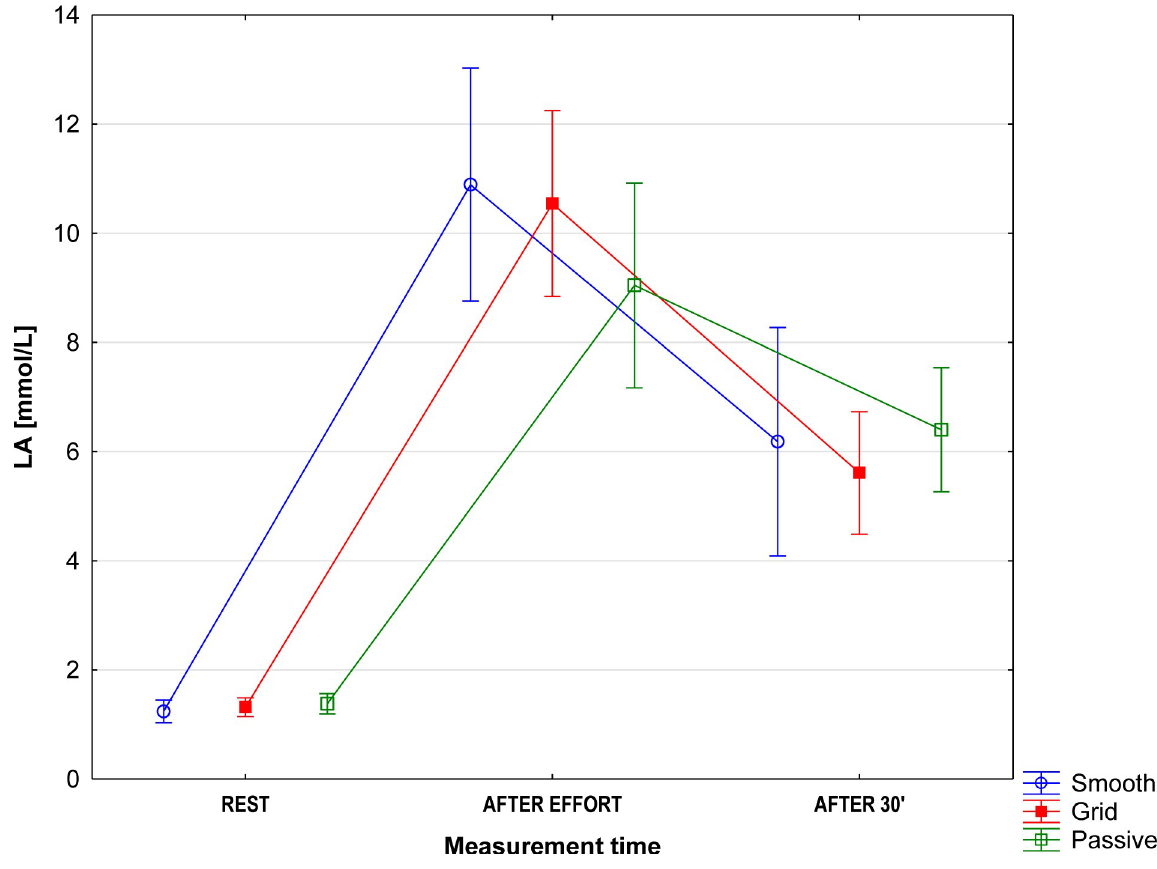
Fig 1. Changes in blood lactate levels, mean values (95%